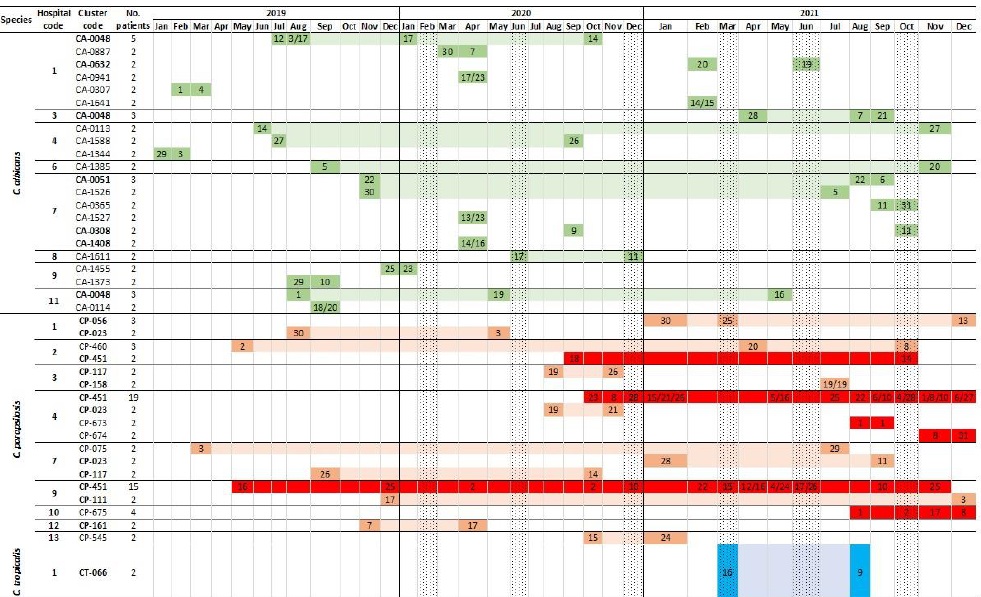
Figure 1. Timeline of C. albicans (green shades), C. parapsilosis (red shades), and C. tropicalis (blue shades) intra-hospital clusters found in blood cultures during the study period (2019–2021). Genotype codes in bold indicate those that were also widespread clusters. Cells in dark colours with numbers indicate the date the genotype was detected in a given patient within each cluster; cells in light shades indicate the latency period (time period spanning two time points in which isolates in a cluster were detected) of the cluster in the hospital. Cells in dark red indicate fluconazole-resistant C. parapsilosis genotypes. Dotted cell columns represent the onset of each COVID-19 wave.